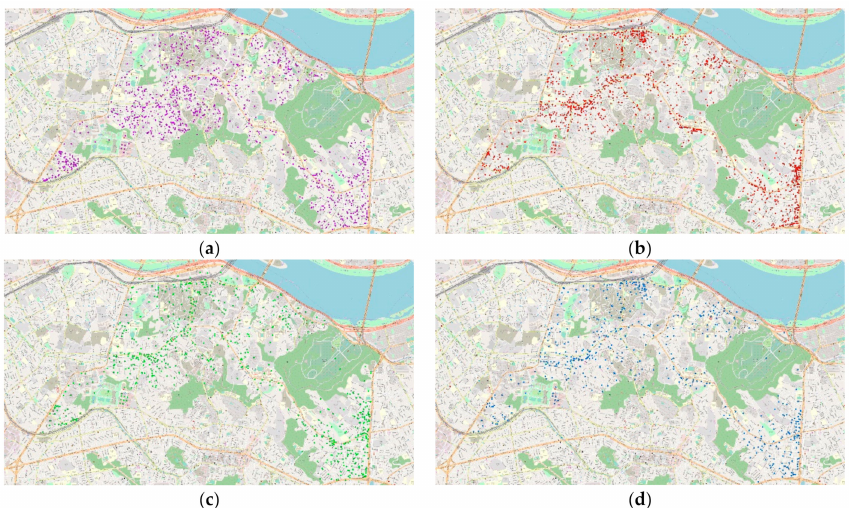
Figure 6. Spatial distribution of clusters; ( a ) Distribution of cluster A; ( b ) Distribution of cluster B; ( c ) Distribution of cluster C; ( d ) Distribution of cluster